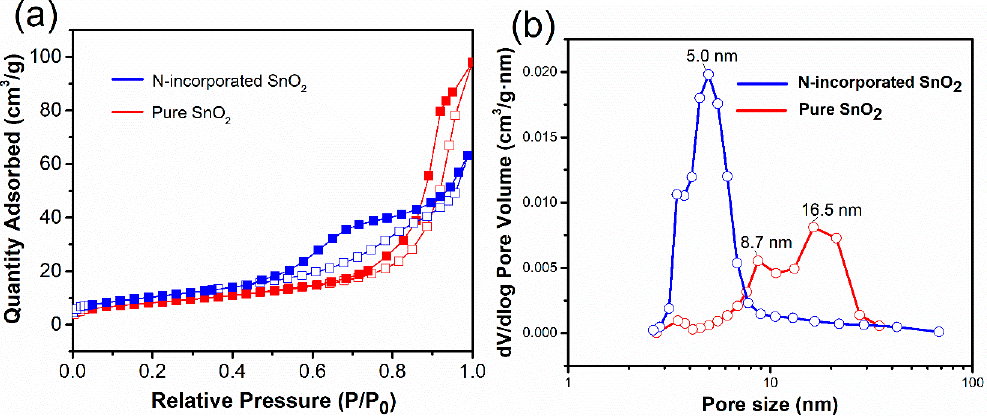
Figure 10. ( a ) N 2 adsorption-desorption isotherm curves and ( b ) pore size distribution curves of the N-incorporated SnO 2 and pure SnO 2 samples.